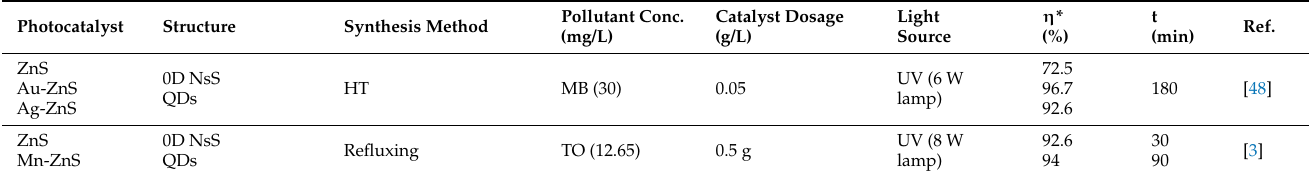
Table 1. ZnS-based photocatalysts for organic pollutants degradation in wastewater